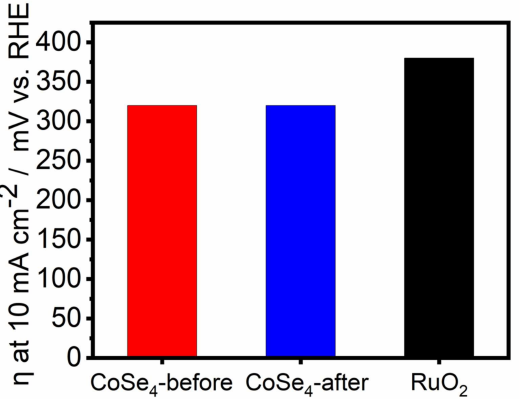
Figure 4. Comparison of achieved overpotentials at 10 mA cm − 2 for CoSe 4 compared with RuO 2 . In addition, the mass activity and turn-over frequency (TOF) of the CoSe 4 @Au catalyst was calculated at an η value of 0.320 V (Table 1). The mass activity was estimated to be 14.15 A g − 1 , indicating better performance than some of the state of the art OER electrocatalysts, such as IrO x and RuO x [49]. The OER TOF at an overpotential of 320